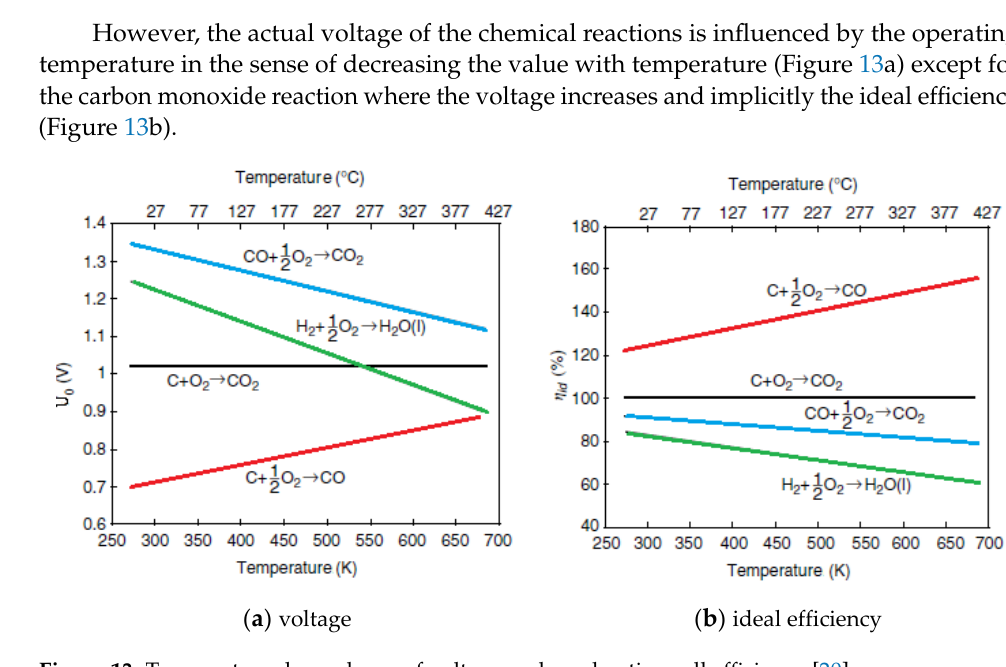
Figure 13. Temperature dependence of voltage and combustion cell efficiency [20].